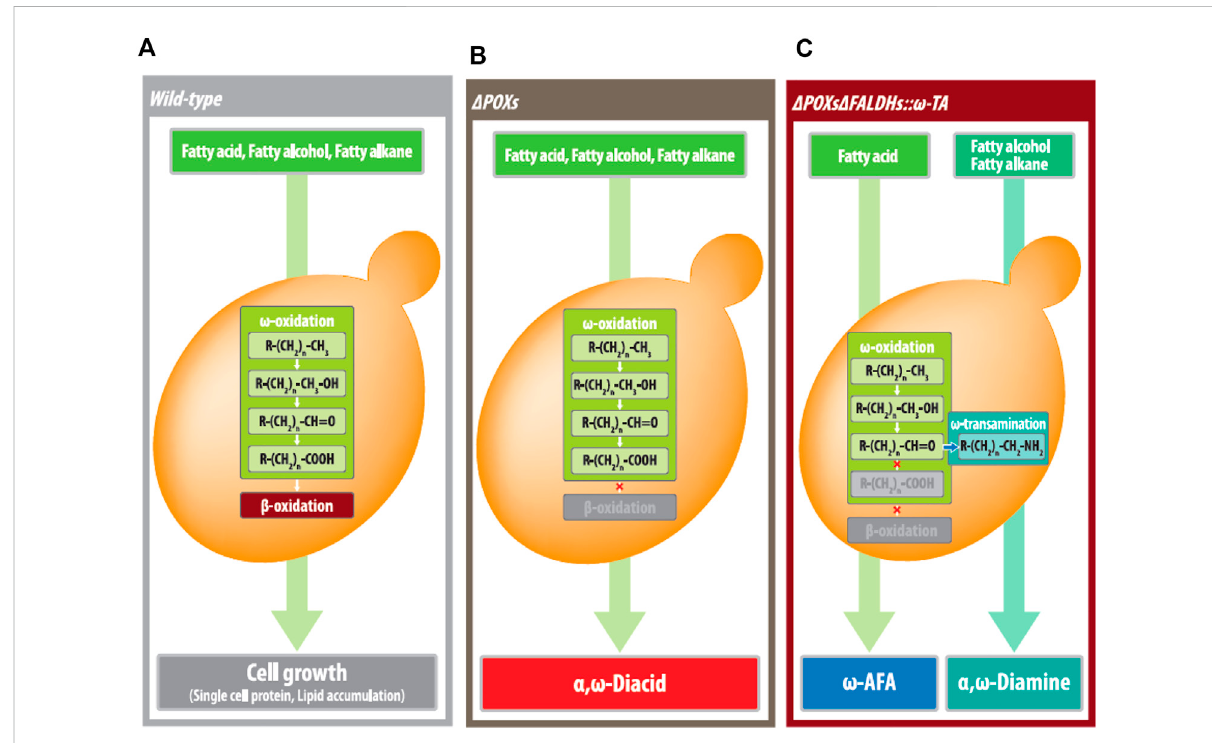
FIGURE 7 Yeast biocatalytic platforms for biotransfomation of MCLC hydrophobic substrates to industrial applicable products including (A) single cell protein or lipid by wild-type strain, (B) α , ω -diacids (fatty alkanes, fatty alcohols, and fatty acids as substrates), by the Δ POXs strains , (C) ω -amino